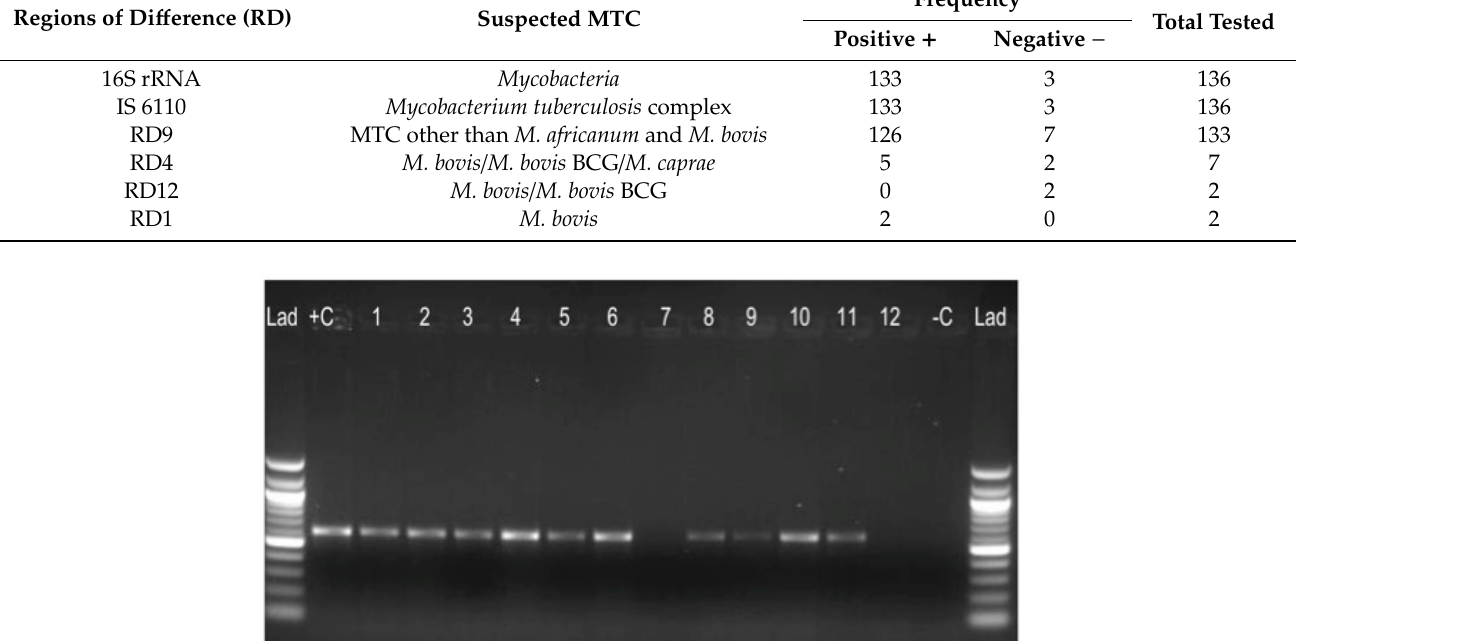
Figure 1. PCR result for RD9 (600 bp) for some of the 133 IS 6110 positive samples. Order on gel: 100 bp Lad, + C: Positive control ( Mycobacterium tuberculosis strain H37Rv), samples 1–12, -C; negative control (nuclease free PCR water). Table 2. PCR results for 136 Pyranizamide (PZA )resistant Mycobacterium tuberculosis complex.